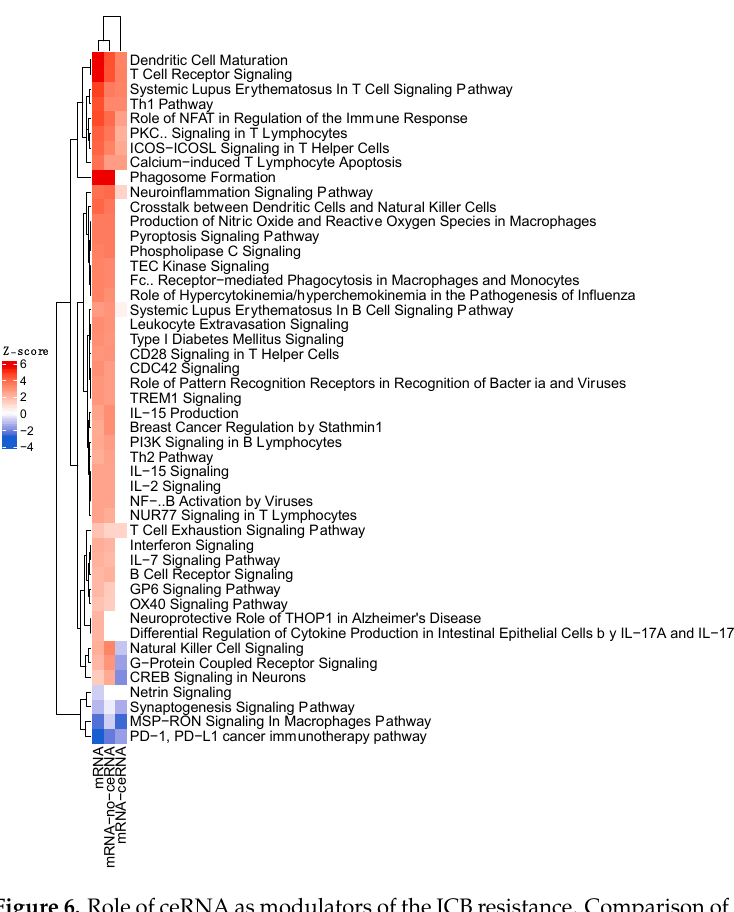
Figure 6. Role of ceRNA as modulators of the ICB resistance. Comparison of the pathways’ aberration according to absence or presence of genes associated with ceRNAs.